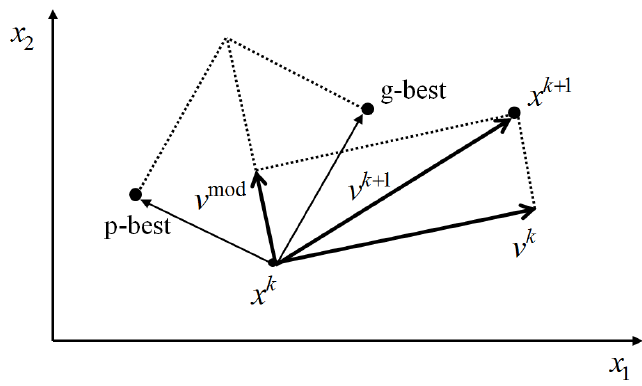
Figure 11. Concept on a change of position and velocity of each